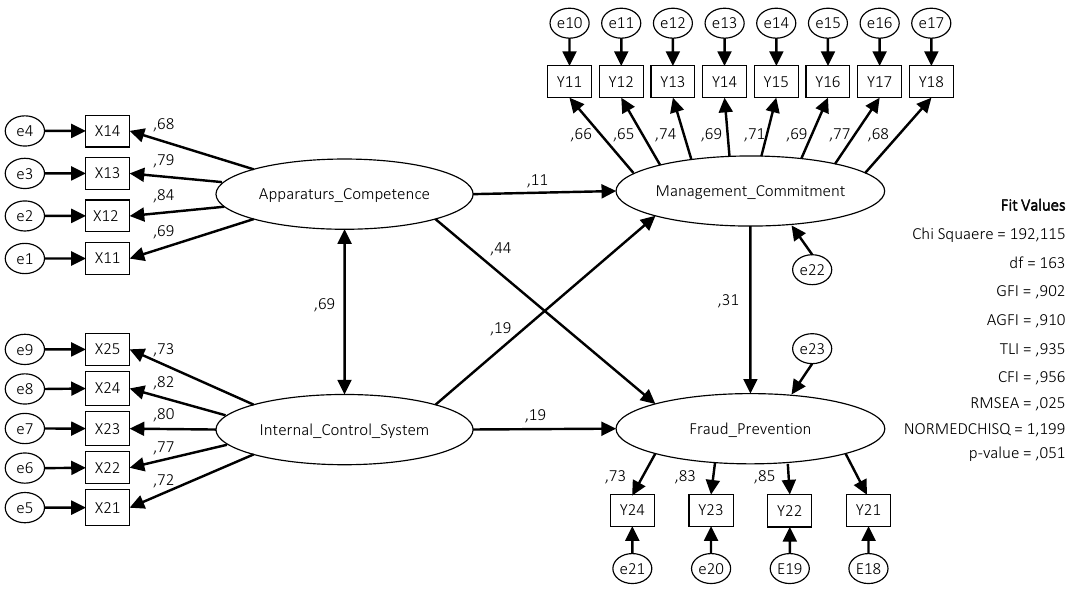
Figure 1. Structural results of the proposed model Table 5. Path coefficient analysis of the structural equations